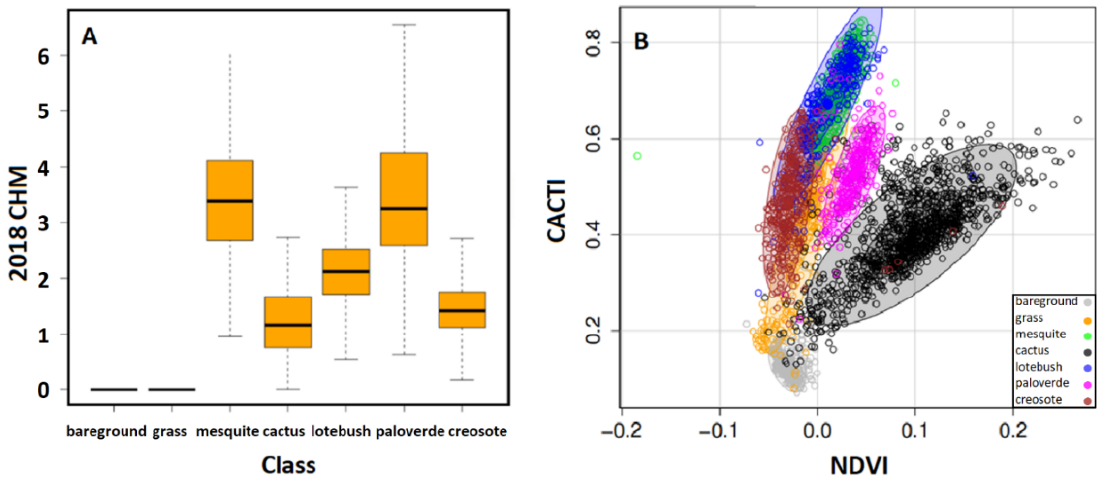
Figure 4. Class ( A ) 2018 CHM differences and ( B ) 2019 CACTI and NDVI model with 95% confi- dence interval ellipses visualizing species delineation and legend indicating the color designated to each class.